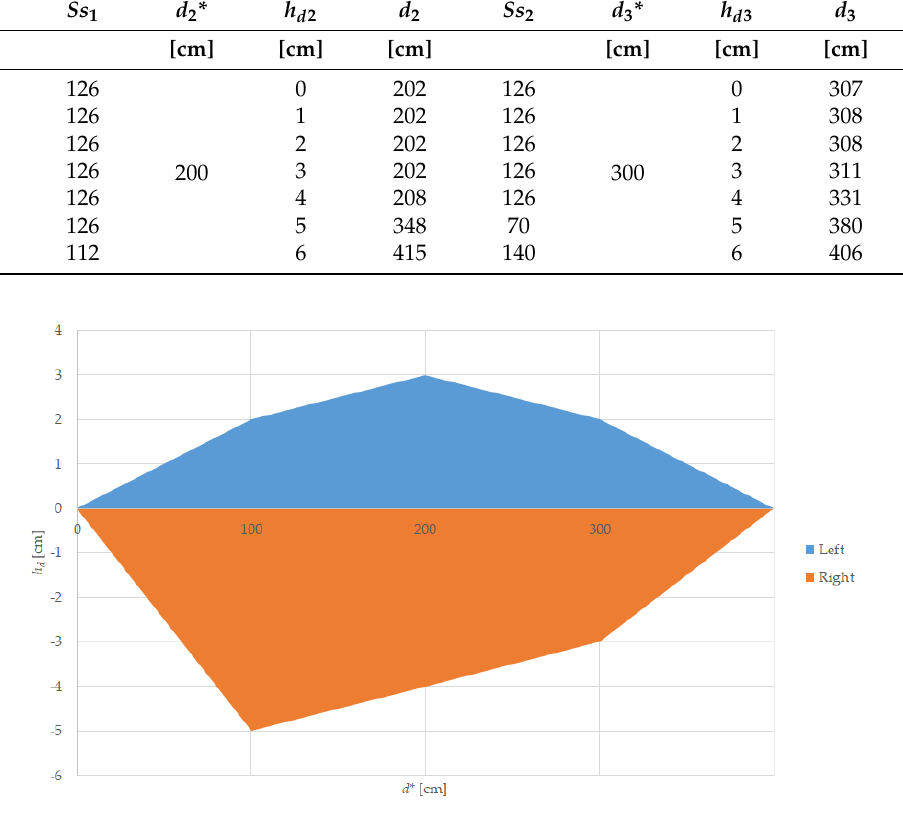
Figure 10. Horizontal displacement sensing area. Table 3. Left horizontal displacement experimental results with tramcar target.